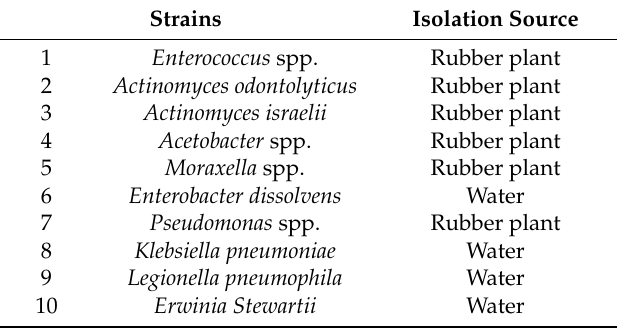
Table 1. Isolation source of bacteria used in this study. Strains Isolation Source 1 Enterococcus spp. Rubber